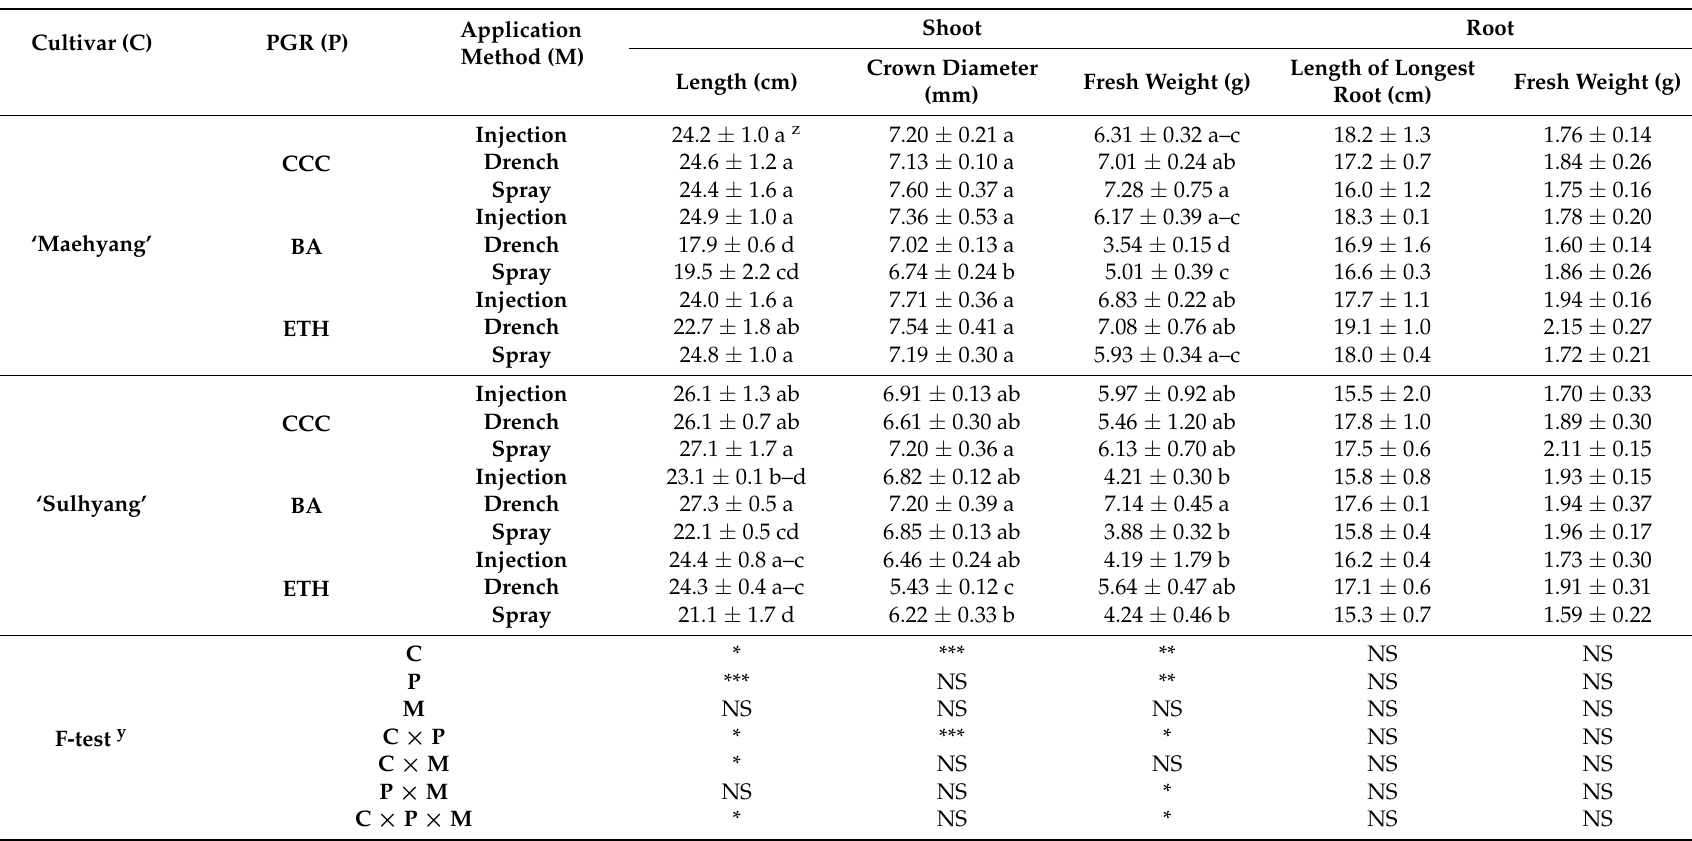
Table 2. Effect of PGR and application method on growth and development of runner plants of strawberries ‘Maehyang’ and ‘Sulhyang’ grown for 30 days. Cultivar